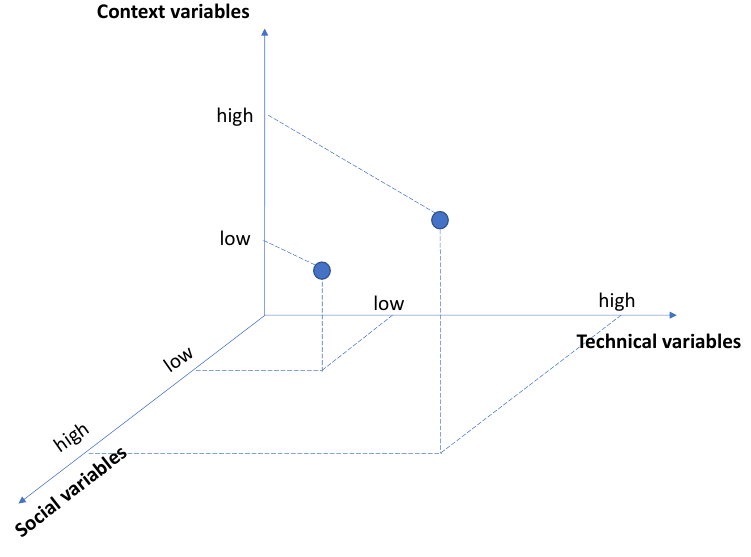
Figure 3. Graphically estimating the risk of a cyberattack using the variables of the